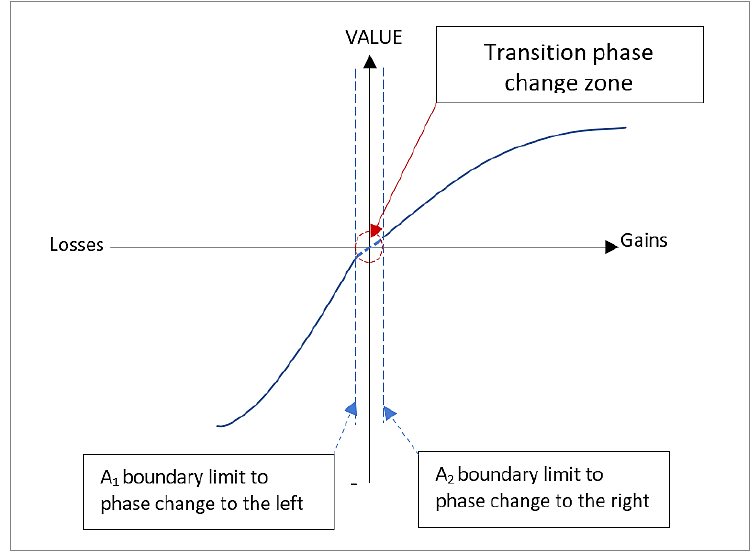
Figure 10. The transition phase change model with constant elasticity at zero point/ reference